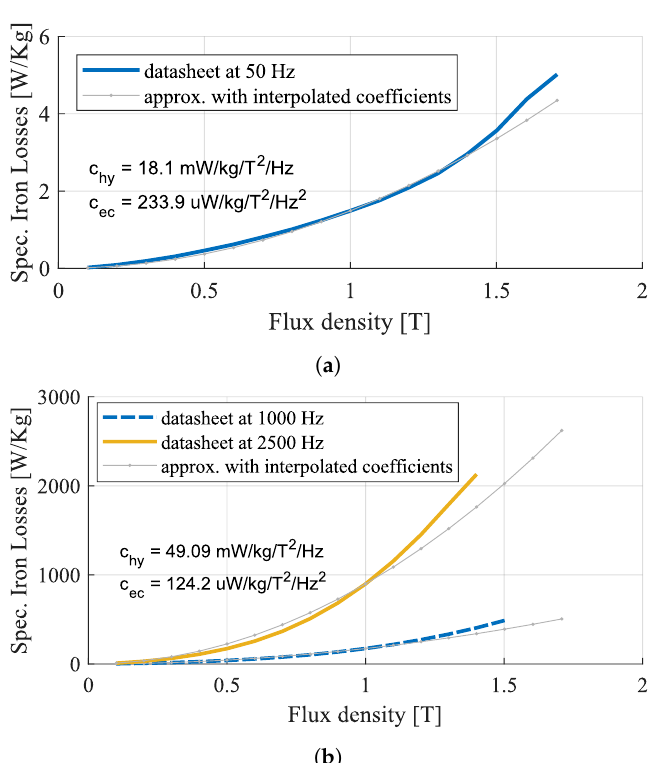
Figure 14. Hysteresis and eddy current coefficient derived for the fundamental and the high fre- quency harmonics. The approximation of the datasheet-specific losses behavior is reported. ( a ) Hysteresis and eddy current coefficient for the fundamental flux density harmonic; ( b ) hysteresis and eddy current coefficient for the high-frequency flux density